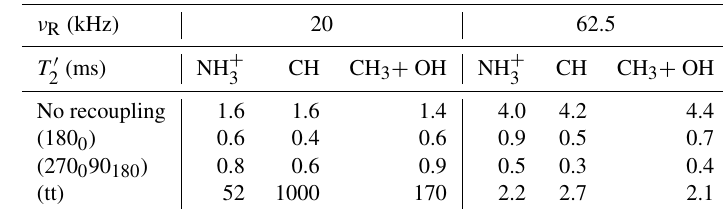
values of AlPO 4 -14 without recoupling or with SR4 2 Table 5. The 1 H T (cid:48) 2 elements. The estimated error bars are equal to 7%.